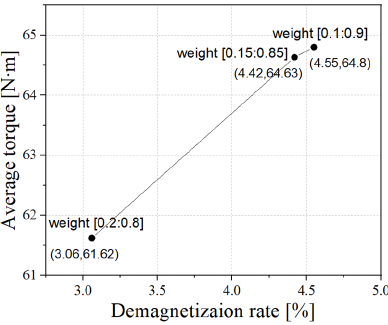
Figure 8. Pareto front of the multi-objective functions.